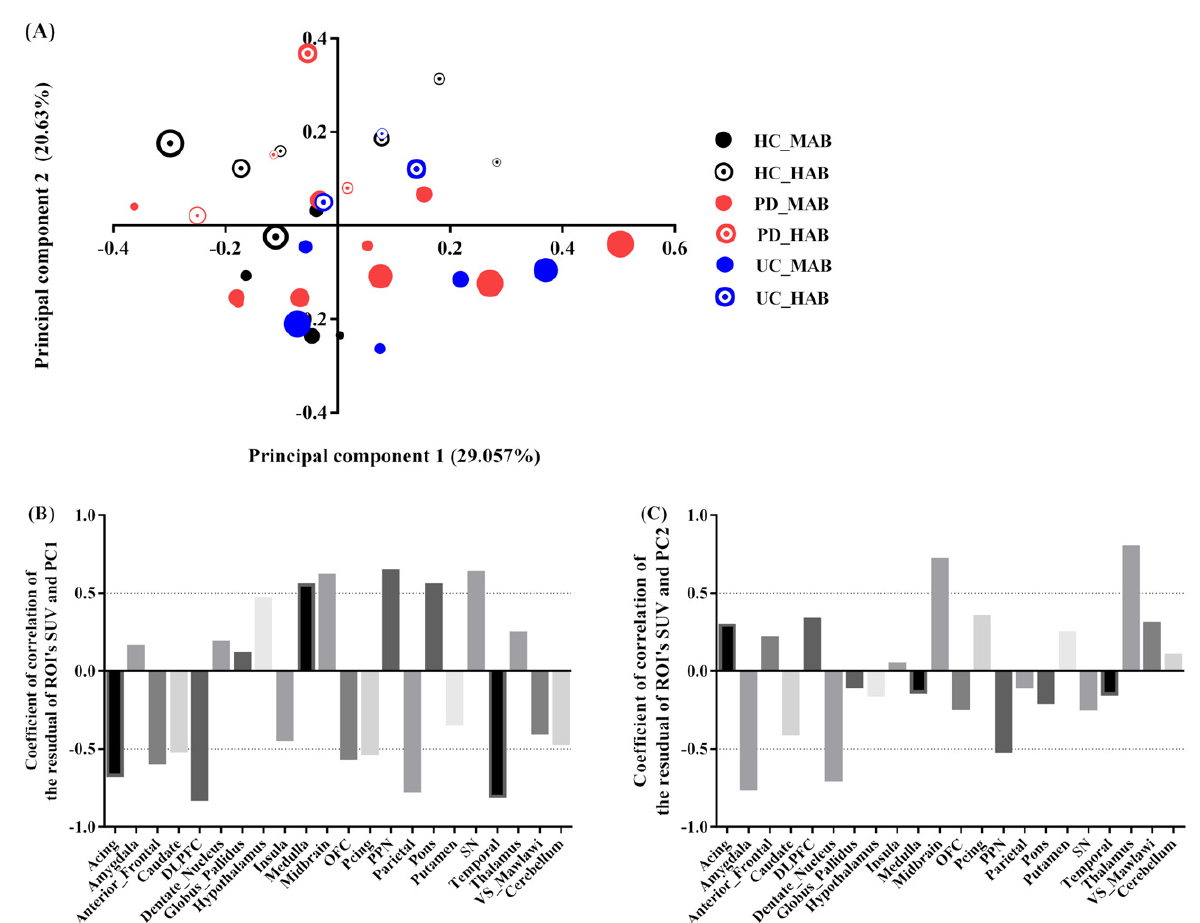
Figure 4. PCA subject’s residual SUV characteristics. ( A ) Factor scores of the observations plotted on the first two components. PC1 explained 29% of the variance and PC2 explained 21% of the variance. The size of markers increases with age. ( B ) Coefficients of correlation between subject’s residual profile of SUV and PC1. ( C ) Coefficients of correlation between subject’s residual profile of SUV and